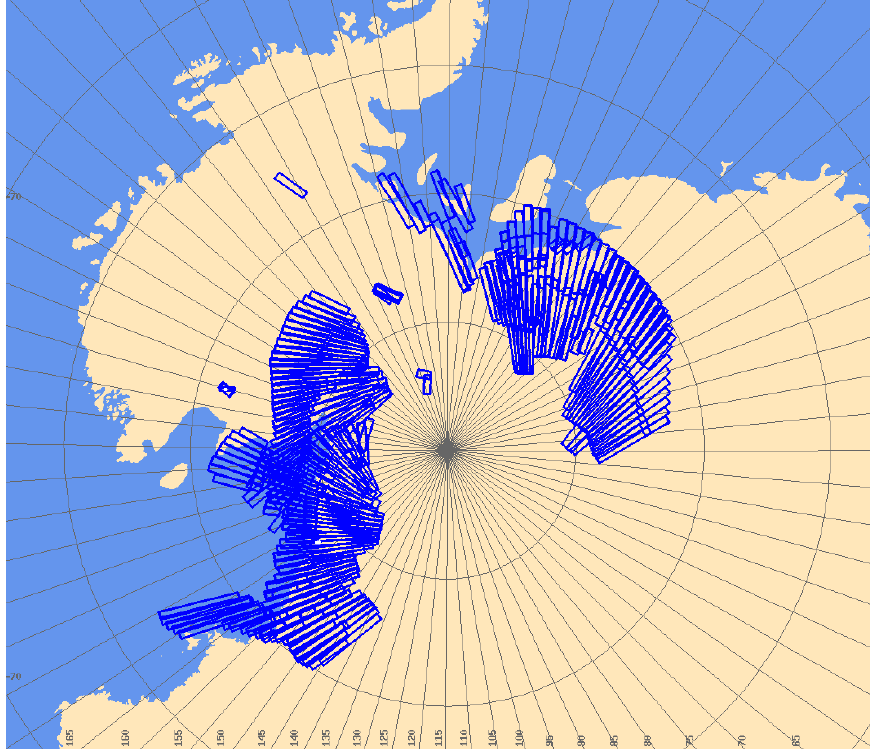
Figure 18. Map visualization of Stripmap left-looking data takes over Antarctica.